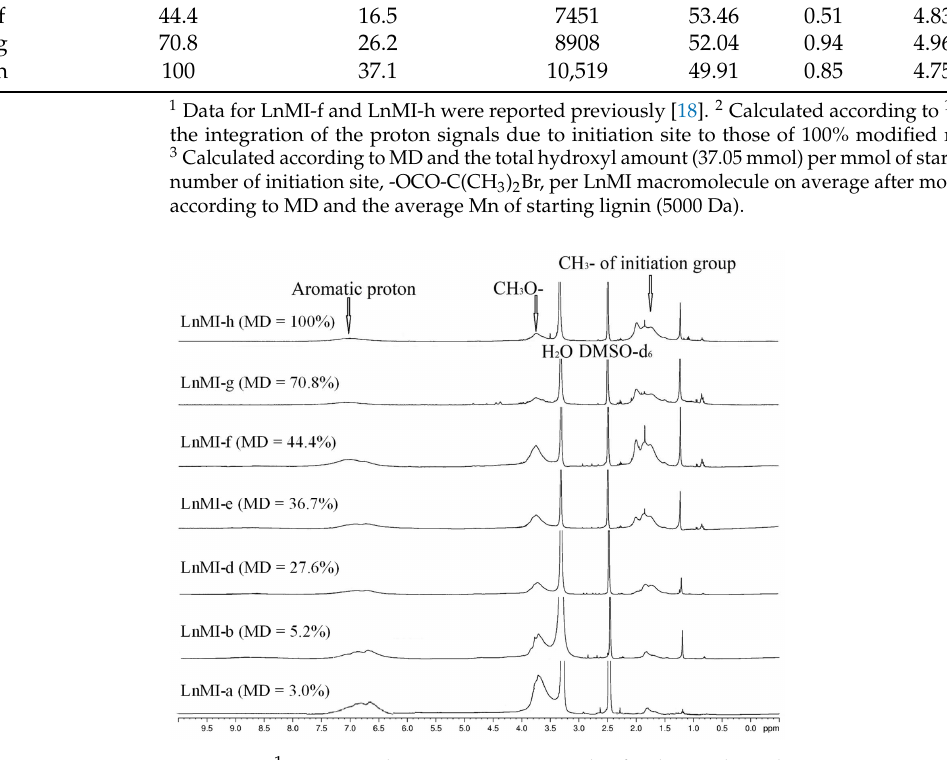
Figure 2. 1 H NMR characterization results for lignin-based macroinitiators (LnMIs) (DMSO-d 6 , 400 MHz, 25 °C). Data for LnMI-f and LnMI-h were reported previously [18] . The solvent residual peak (δ 2.5 ppm) and the water peak (δ 3.3 ppm) were labelled in these spectra.